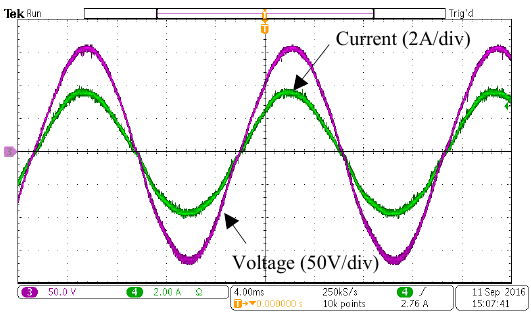
Fig. 14. Output voltage and output current when L g = 19.5 mH ( k p = 2)